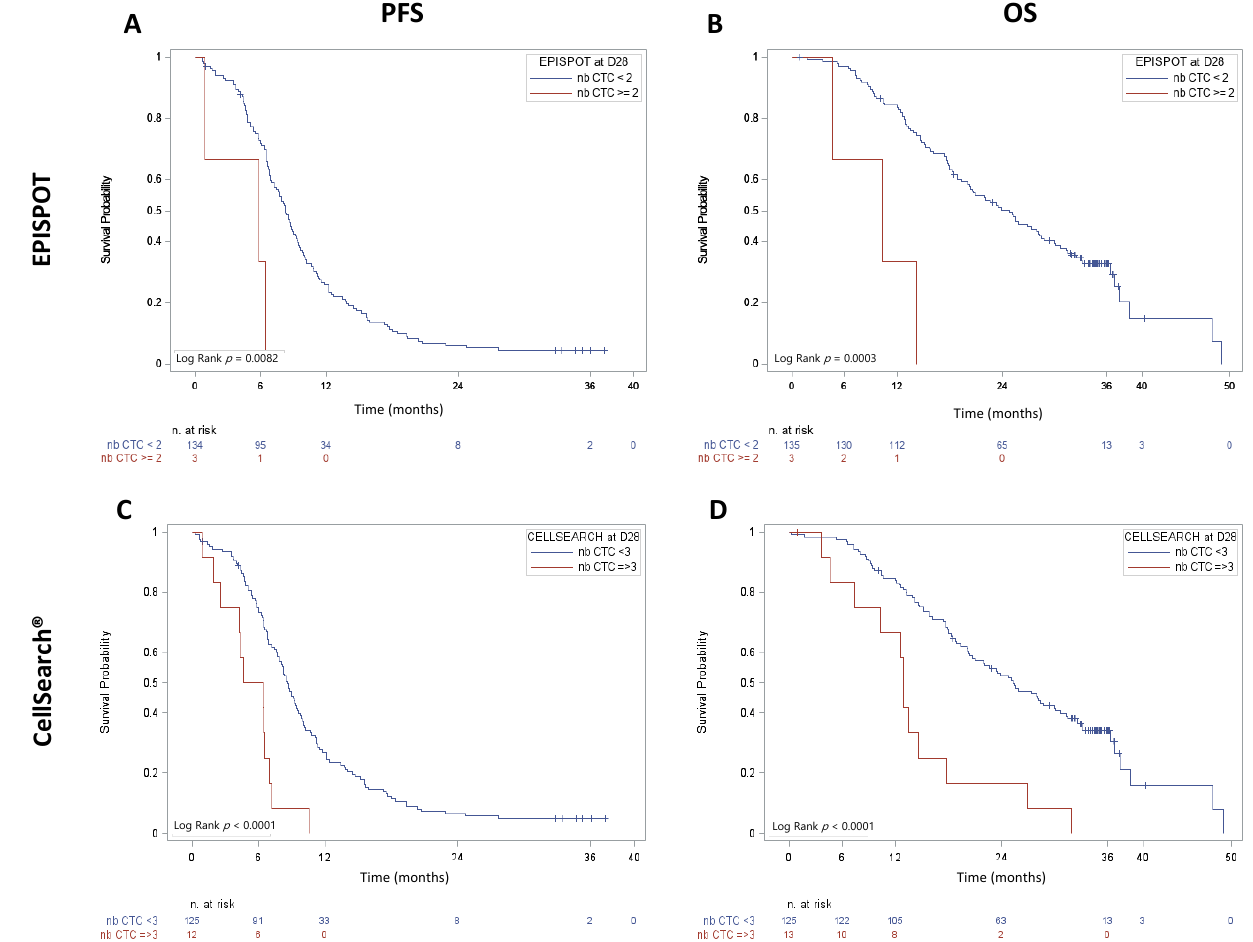
Figure 2. PFS and OS in patients with metastatic CRC at D 28 . CTCs were enumerated after the first two chemotherapy cycles (D 28 ) with the ( A , B ) CK19-EPISPOT ( ≥ 2 vs. <2) and ( C , D ) CellSearch ® ( ≥ 3 vs. <3) assays.